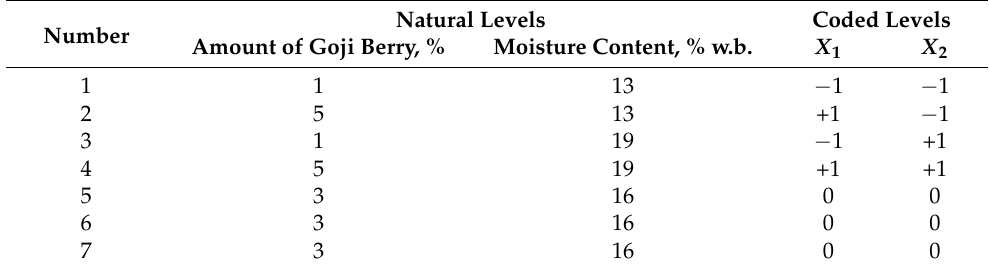
Table 1. Experimental